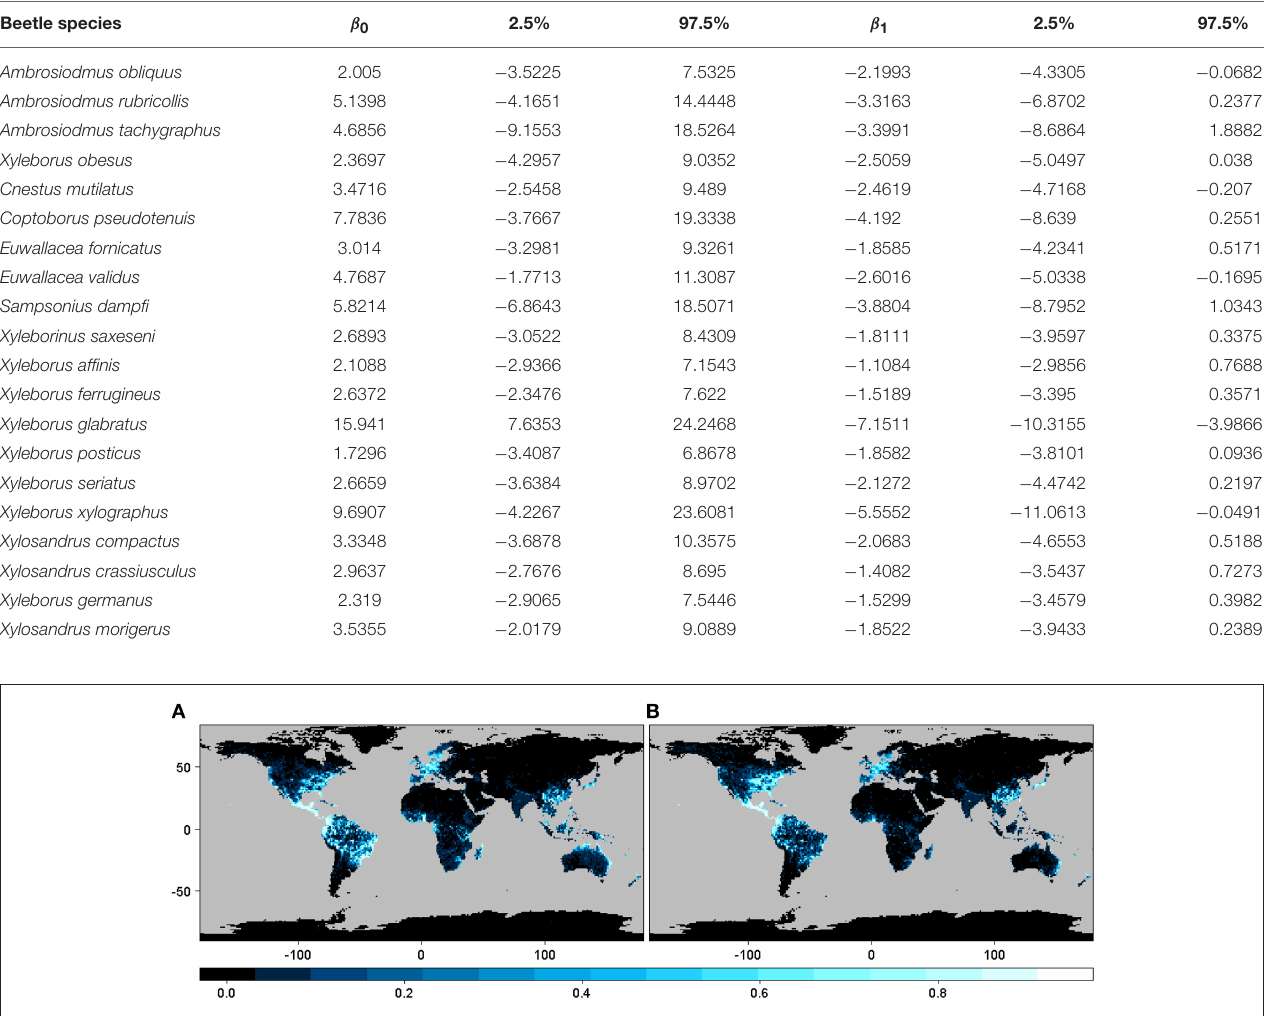
TABLE 1 | Logistic regression coefficients and confidence intervals.